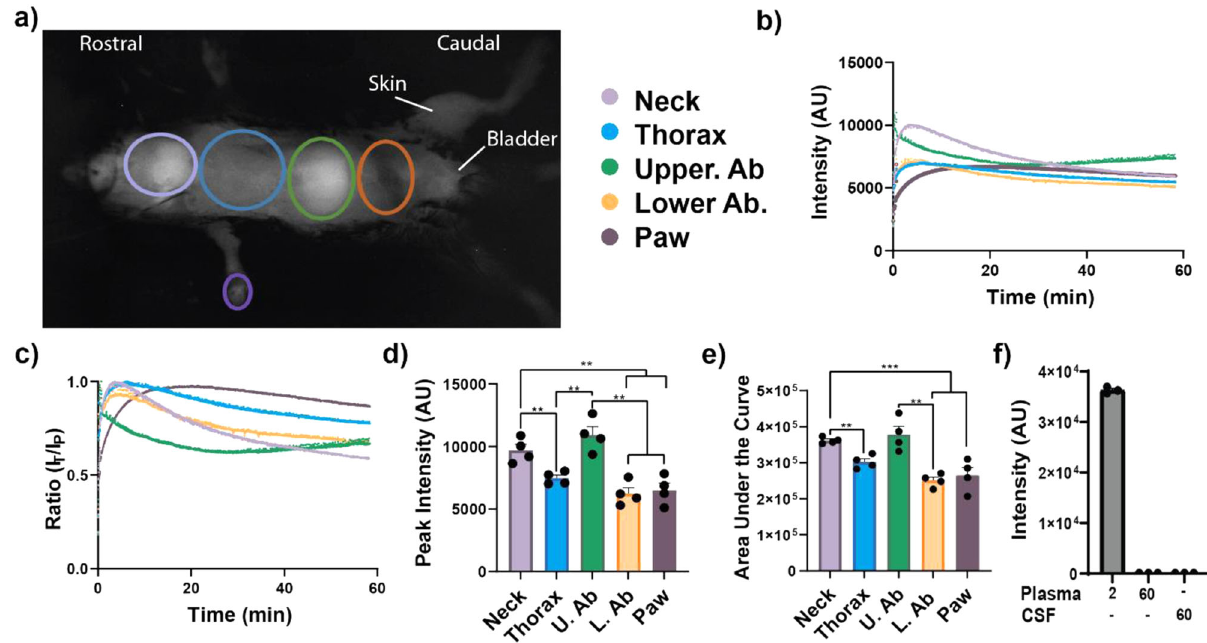
Fig. 1 Body-wide biodistribution and slow elimination of a SP in mice. a External in vivo dynamic SP-NIRF image of a mouse after its intravenous injection (after a few minutes). Regions of interest (ROIs) selected for the analysis. b Representative SP-NIRF intensity-time pro fi le for each ROI over 60 min. c Standardization of data by dividing intensities at each time point by the peak intensity ( I T / I P ratio). d Peak intensity for the ROIs. e Area under the curve (AUC) for the ROIs. Values are mean ± SEM, N = 4 young male mice (2 – 3 months old). f Plasma intensities at 2 and at 60 min, and CSF levels at 60 min. Values are mean ± SEM, N = 3 young male mice. AU (arbitrary